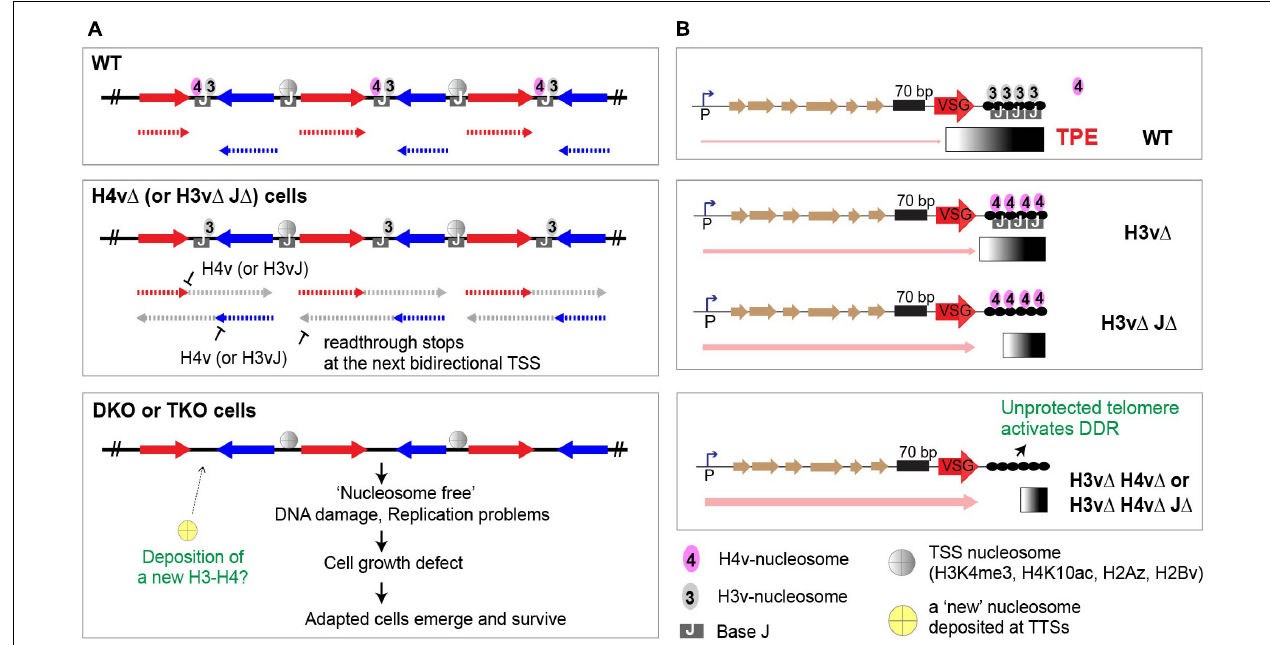
FIGURE 9 | Roles of H3v, H4v, and base J in transcription and genome maintenance. (A) At TTSs, J-modified DNA wraps around nucleosomes containing H3v or H4v. H4v nucleosomes signal the RNA pol II machinery to stop at TTSs. Pol II that missed the stop sign continues to progress until it reaches the next divergent transcription start site (TSS). Simultaneous absence of H3v and J affects H4v nucleosome function by changing the TTS chromatin structure. Upon removal of H3v in DKO or TKO cells, nucleosome-free TTS DNA becomes fragile, accumulates replication stress and DNA lesions, and activates DNA damage response (DDR). A cell may deposit a functional pair of H3-H4 PTMs. A survivor clone with new epigenetic marks emerges if it could form stable nucleosomes and TTS chromatin structure and inherit. (B) The synergistic effect caused by H3v and H4v double KO in VSG silencing suggests that H4v nucleosome may bind telomere repeats in the absence of H3v. The loss of both H3v and H4v nucleosomes at telomeric regions could leave telomeres unprotected, leading to chromosome abnormalities, disruption of heterochromatin structure, and loss of VSG silencing. Differing degrees of VSG derepression level between BES VSGs in a DS clone and also between DS clones suggest that individual telomere in survivors may not have the same epigenetic